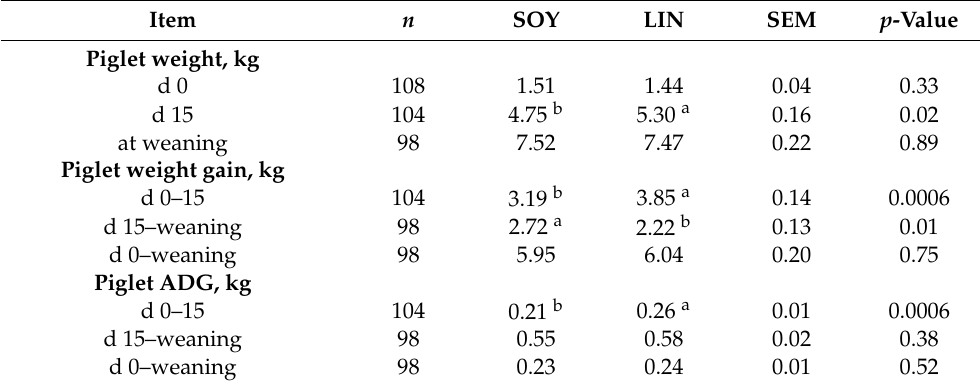
Table 2. Growth performance of pre-weaned piglets